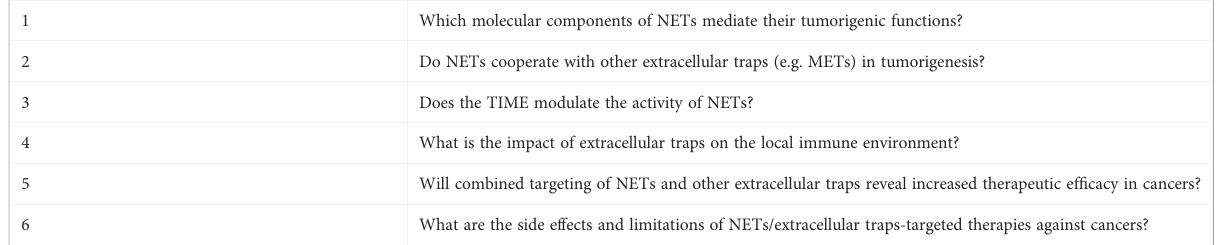
TABLE 1 Future questions on the role of extracellular traps in